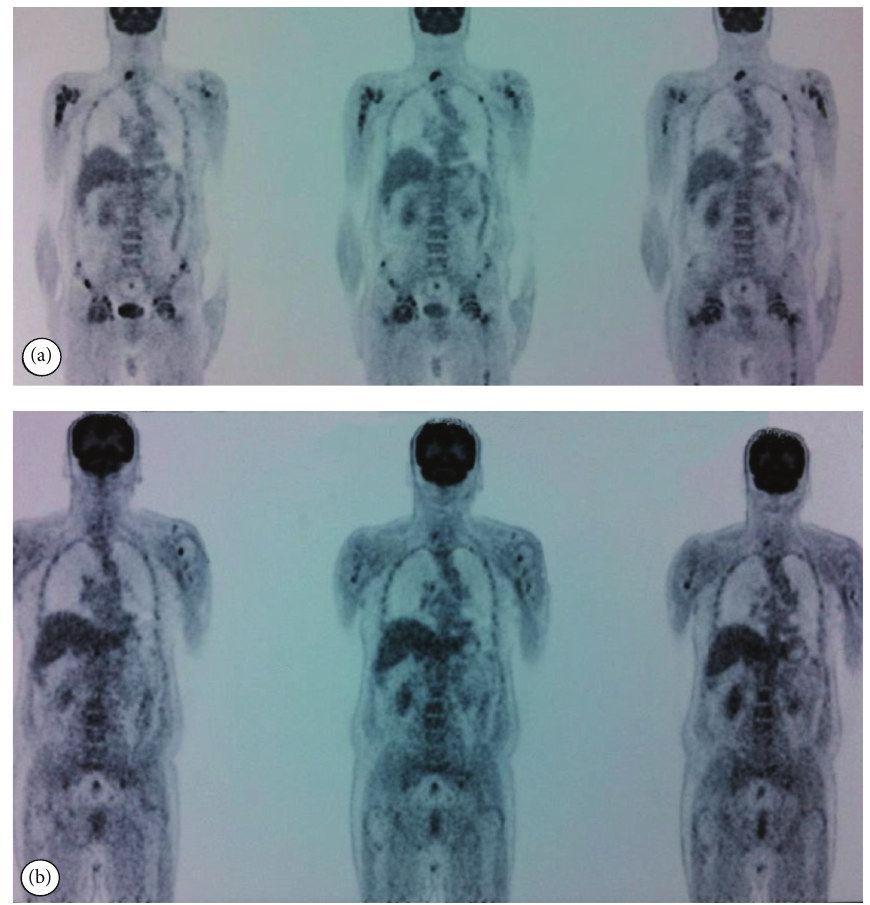
Figure 6: PET scan at diagnosis and 8 weeks after chemotherapy. (a) There was increased FDG uptake on axial skeleton, pelvis, and both femurs at diagnosis. (b) Follow-up PET scan demonstrated marked metabolic response with decrease in uptake of multiple metastatic lesions on both proximal humeri, the right lamina of C6 vertebra, and both first